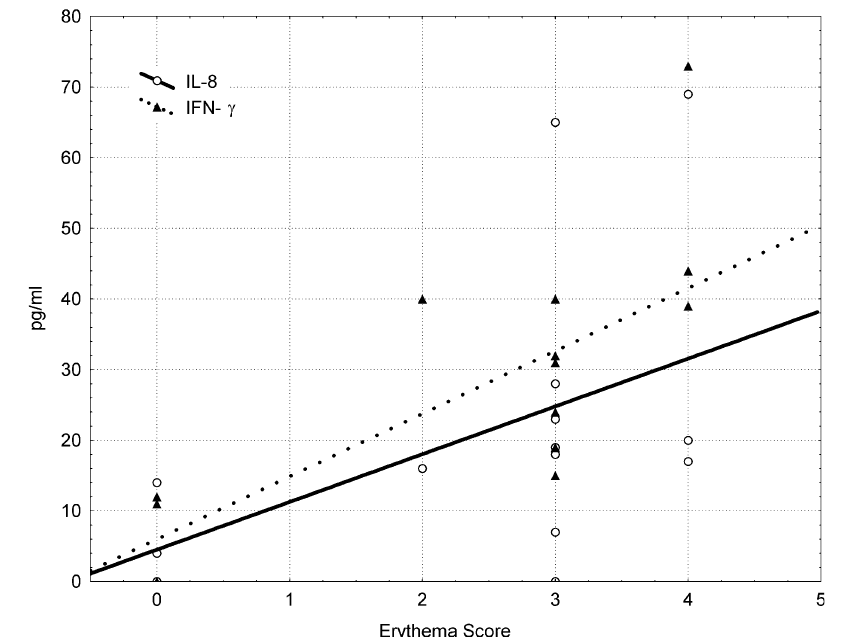
FIG. 1. Scatter plot of IFN- g (closed triangles) and IL-8 (open circles) serum levels in correlation with erythema score. Lines denote the regression curve